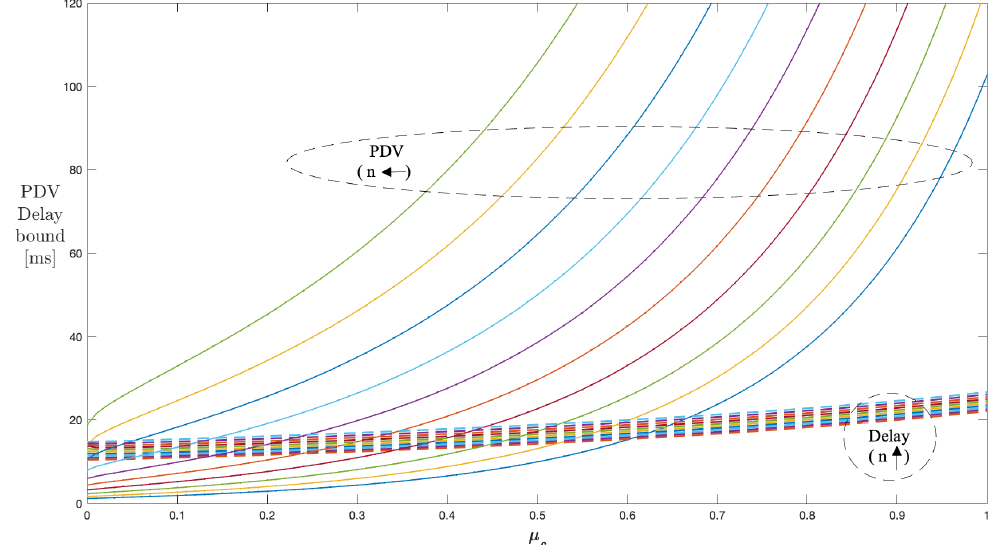
Figure 9. Impact of n and µ c on the PDV bound in a multi-stage network (constant λ c